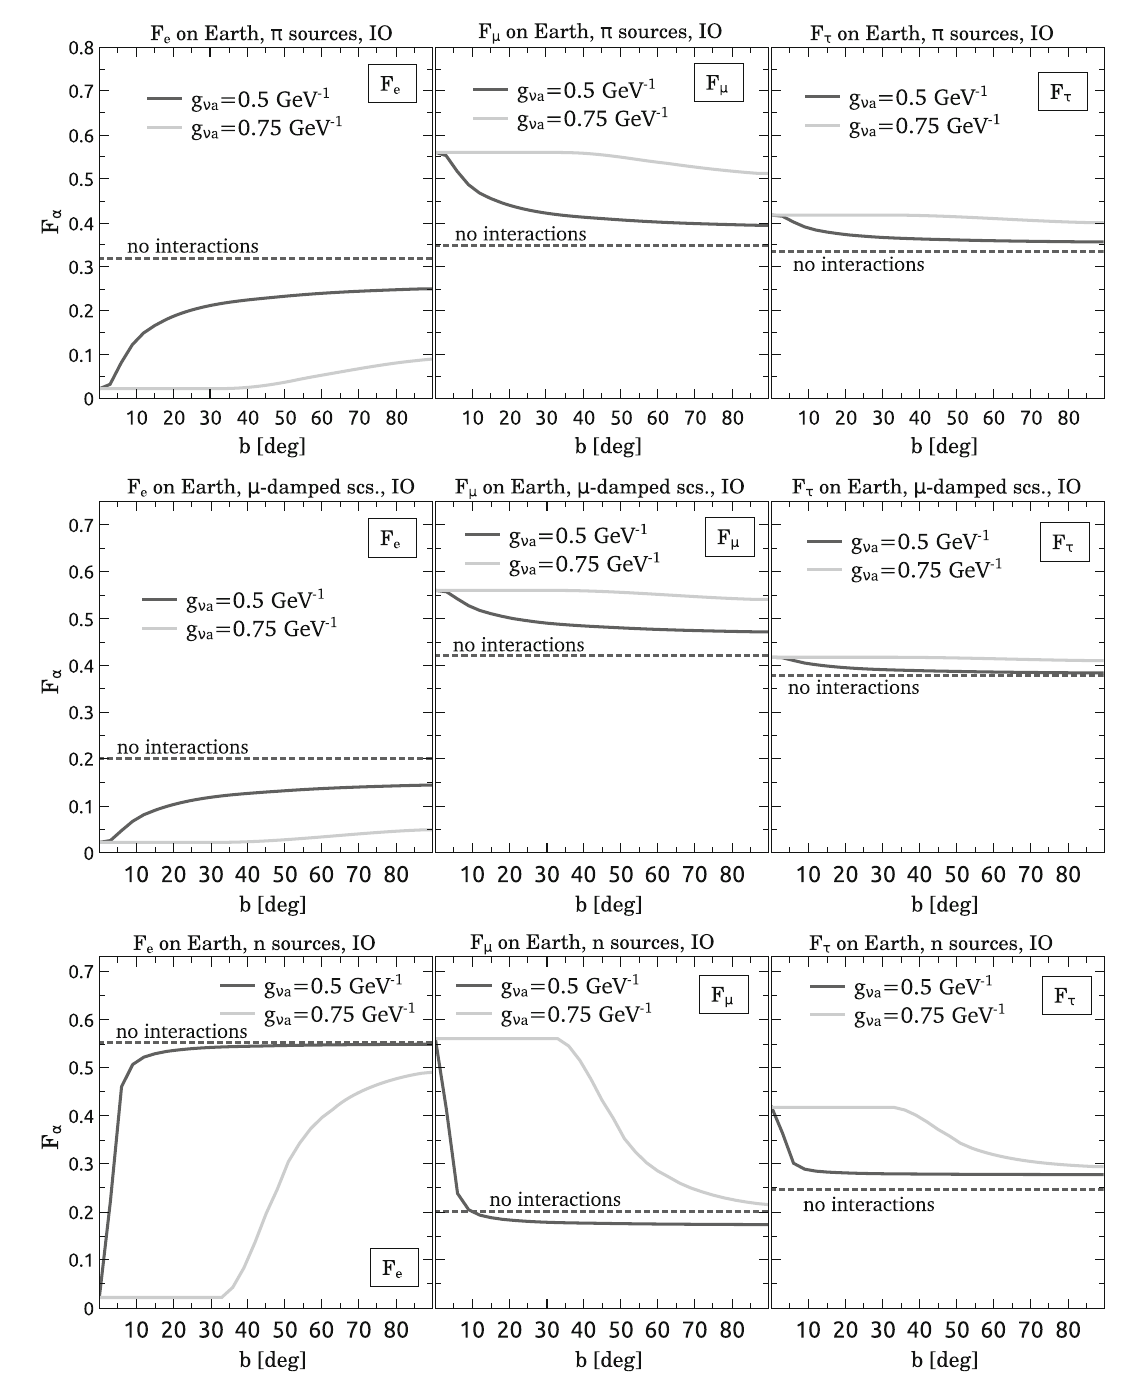
Fig. 10 Flavor ratios of the integrated fluxes in the IO case as a func- tion of the galactic latitude b corresponding to the arrival direction, for a fixed galactic longitude l = 0 ◦ . The electron, muon, and tau fla-